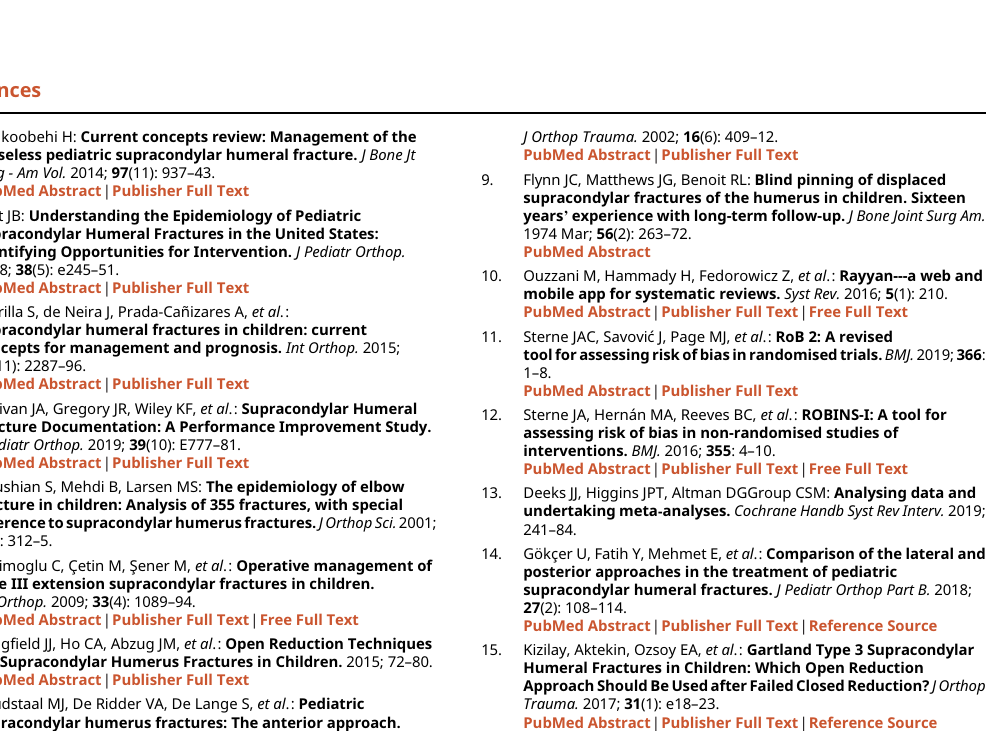
Figshare: PRISMA checklist and flowchart for 'Lateral versus posterior surgical approach for the treatment of supra- condylar humeral fractures in children: a systematic review and meta-analysis'. https://doi.org/10.6084/m9.figshare. 14740545.v1. 29